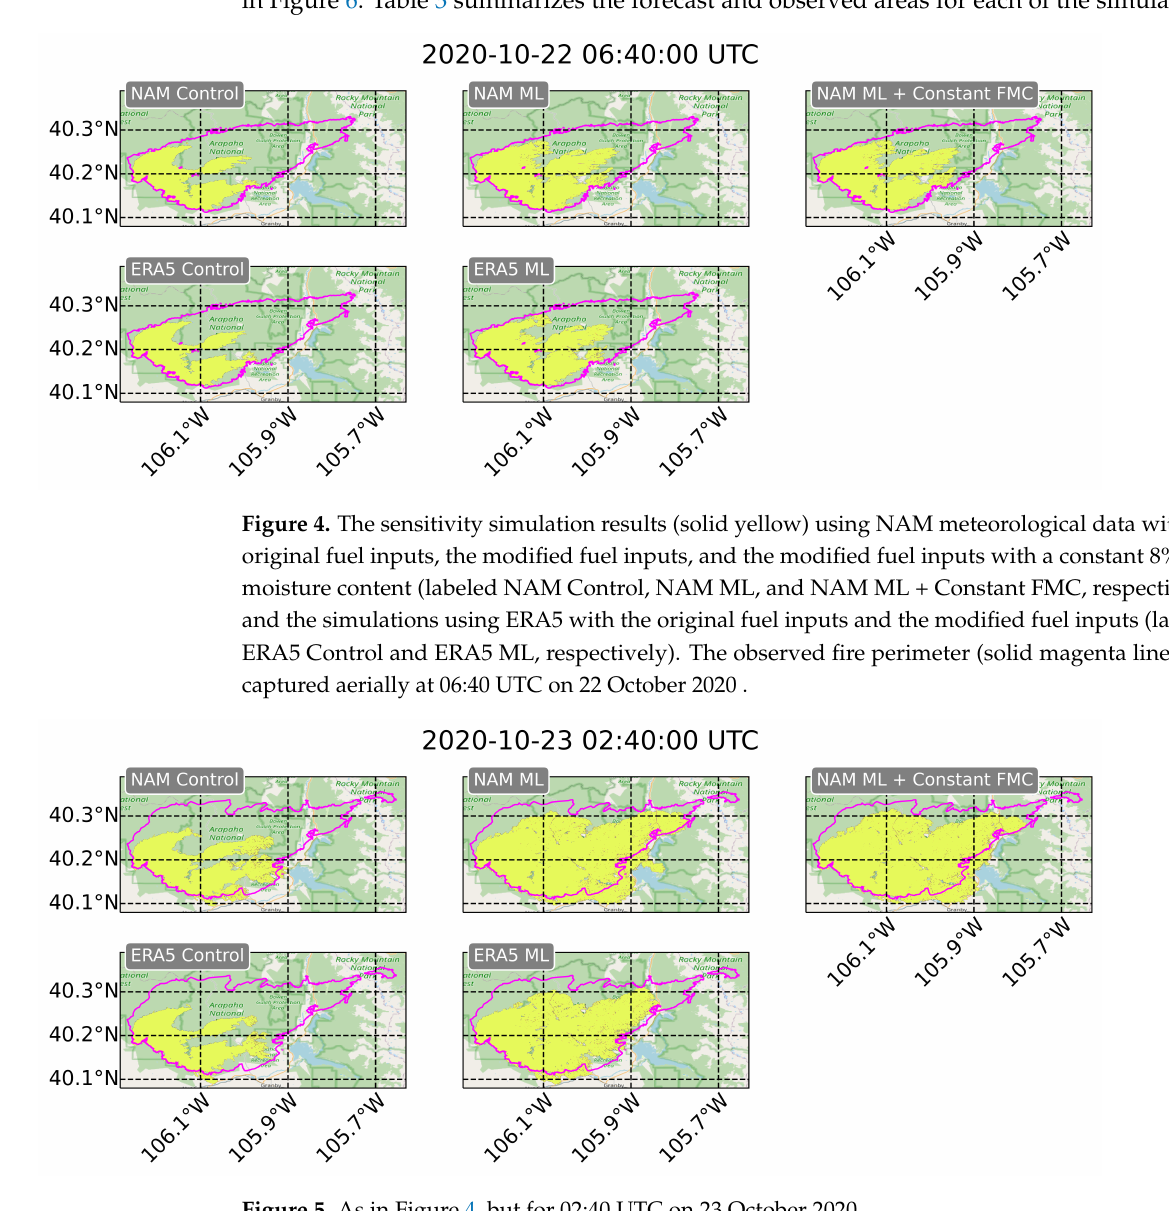
Figure 5. As in Figure 4, but for 02:40 UTC on 23 October